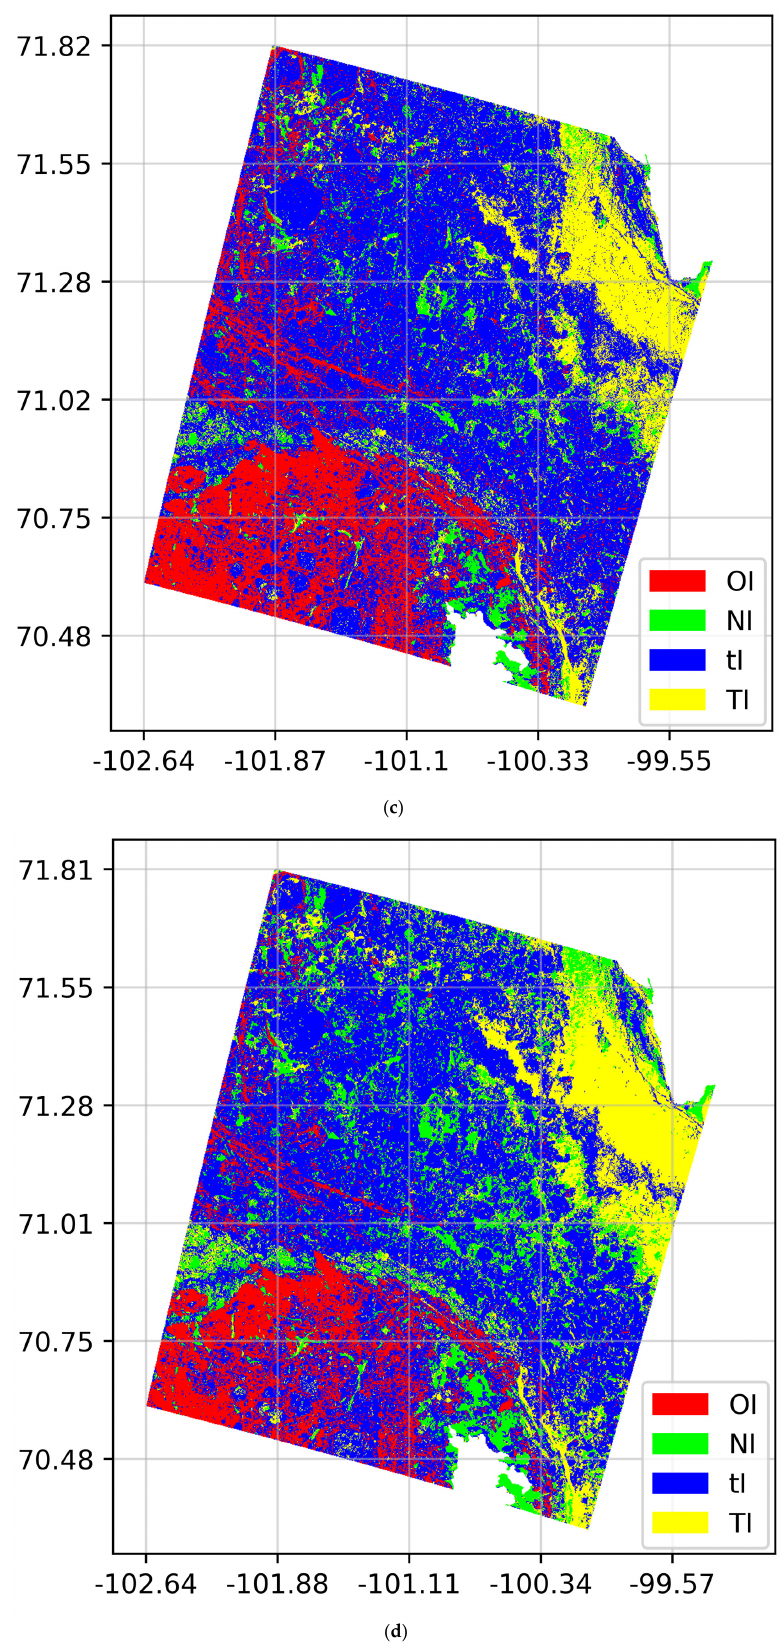
Figure 10. Sea ice classification results for ( a ) scene 4 using ( b ) SCNN, ( c ) ResNet18, and ( d ) proposed method.